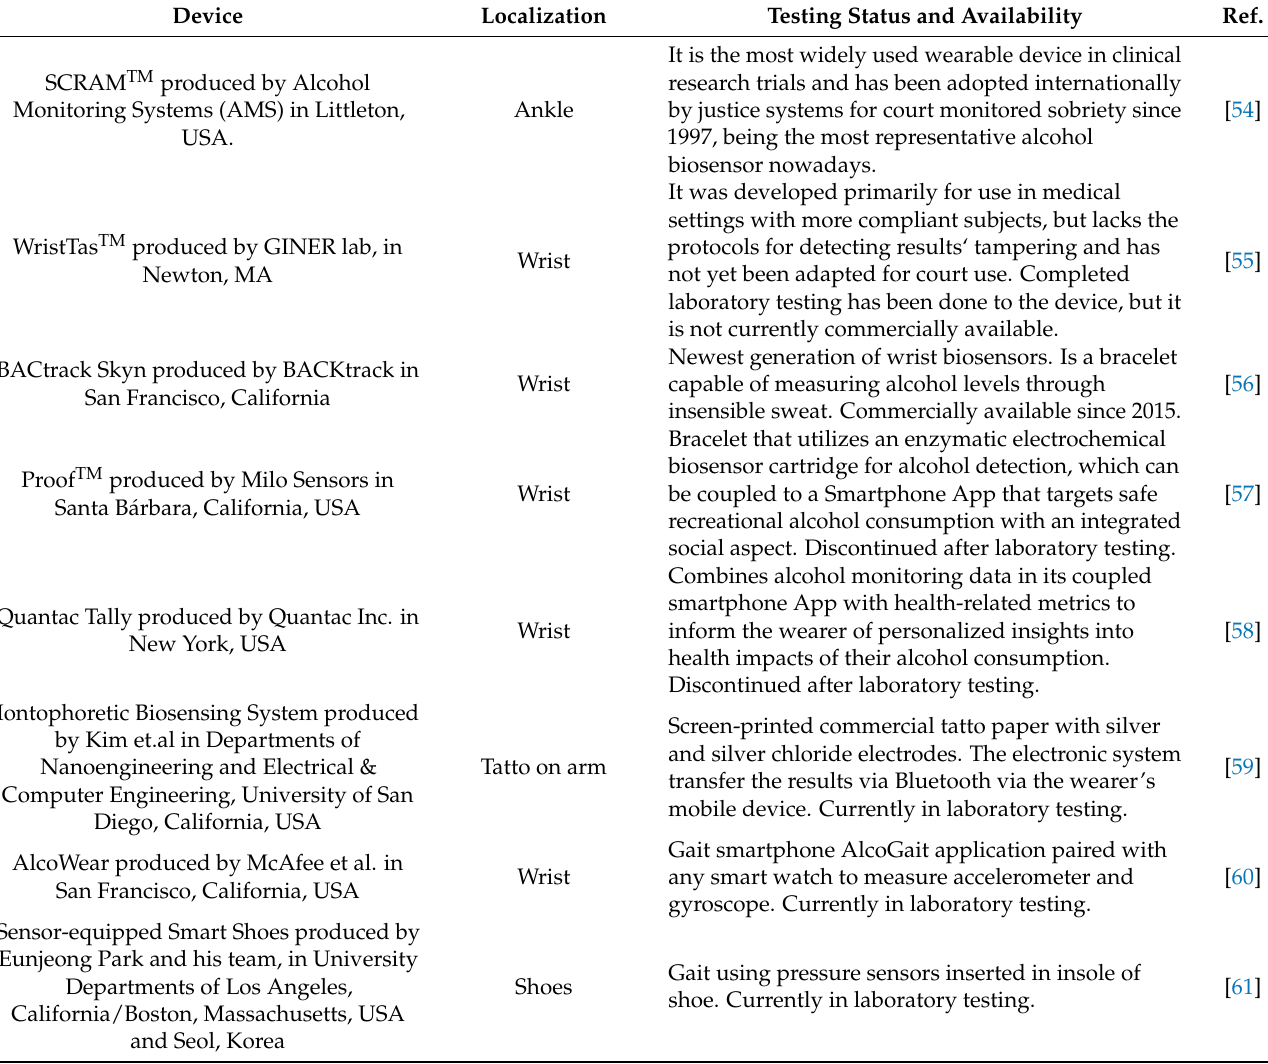
Table 1. Overview of wearable/flexible biosensors to detect alcohol in